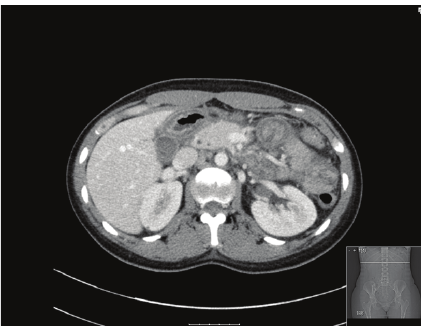
Figure1:Abdominalcomputedtomography(CT)scanatadmission indicated a thickened edematous bowel loop adjacent to pancreas with mild homogenous edema of pancreas.